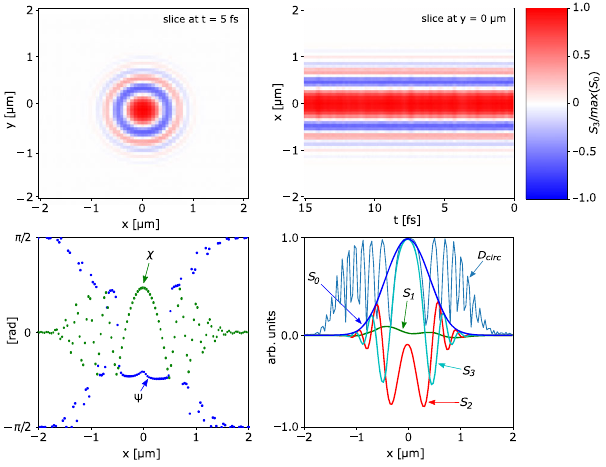
FIG. 11. Polarization properties of radiation for the setup geometry optimized for spatial polarization shaping with crossed planar undulators. Notation and averaging are the same as in Fig. 10. Radiation power is 1.5